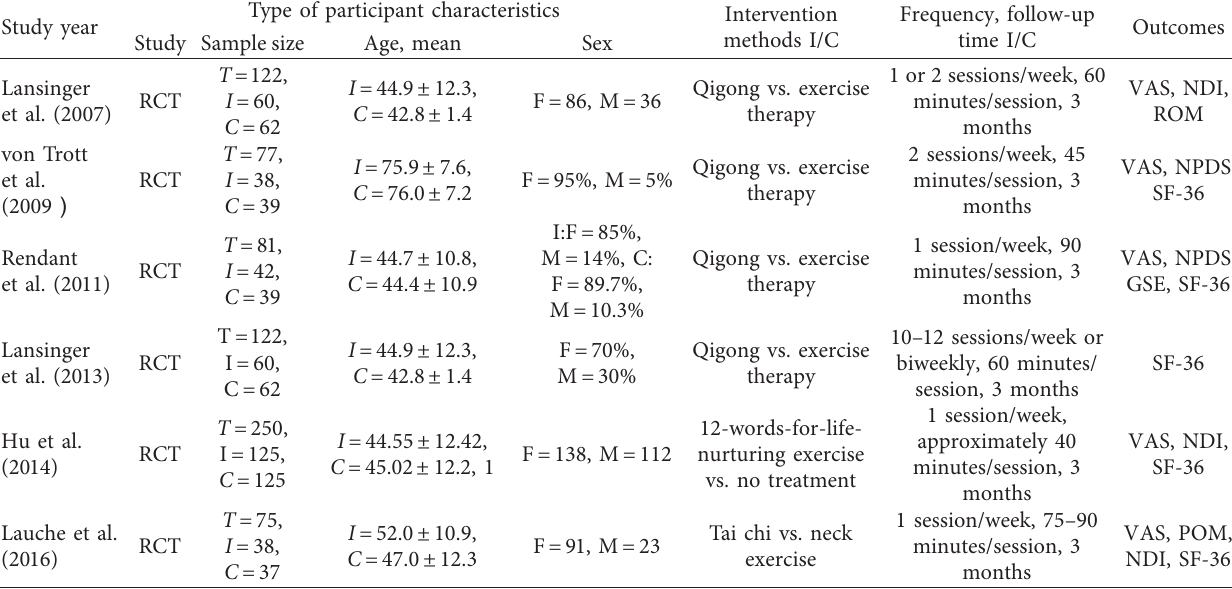
Table 2: Characteristics of the included studies.